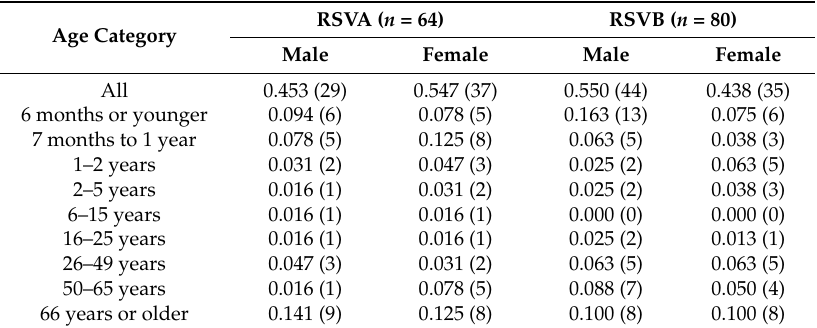
Table 1. Demographic of the patient data used in this study. Ratios for gender and age categories are shown for respiratory syncytial virus (RSV) A and B. Total numbers are shown in